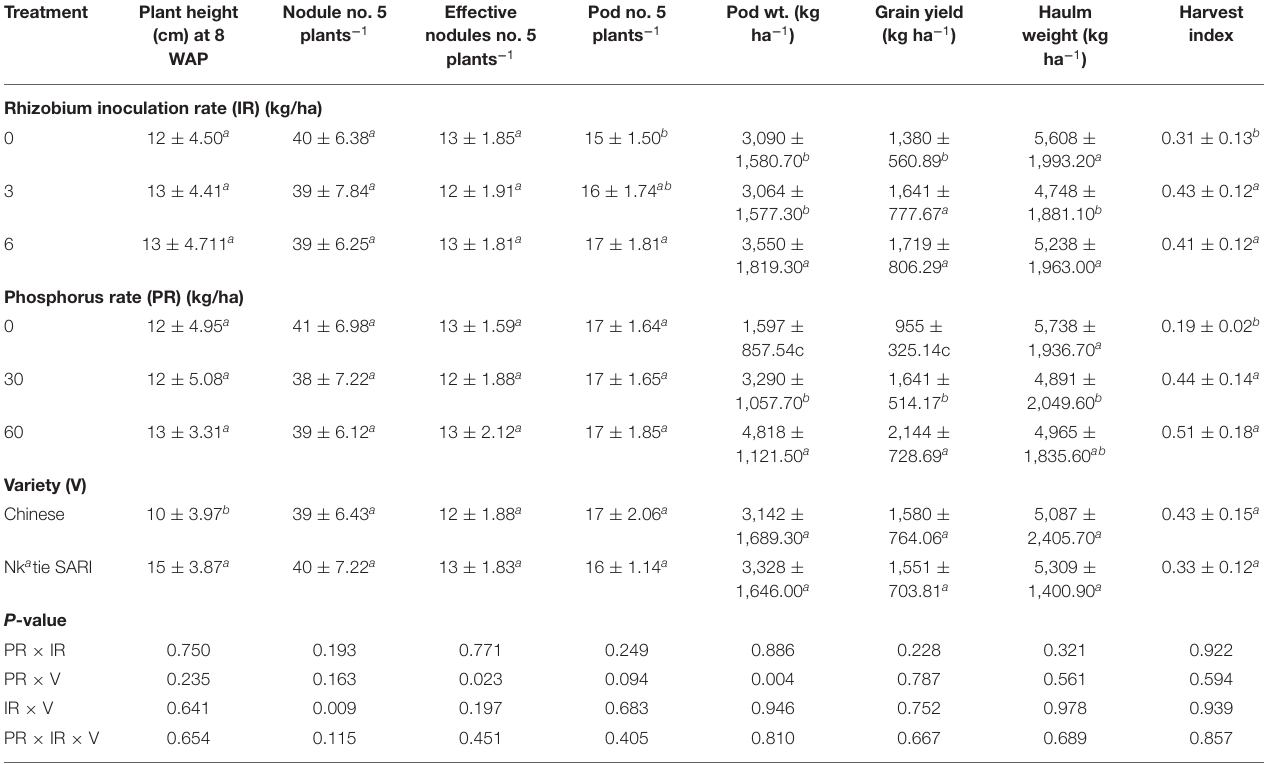
TABLE 4 | Plant height, nodulation, yield, and yield components of groundnut as affected by variety, phosphorus, and rhizobium inoculation rates in the on-farm experiment. Treatment Harvest